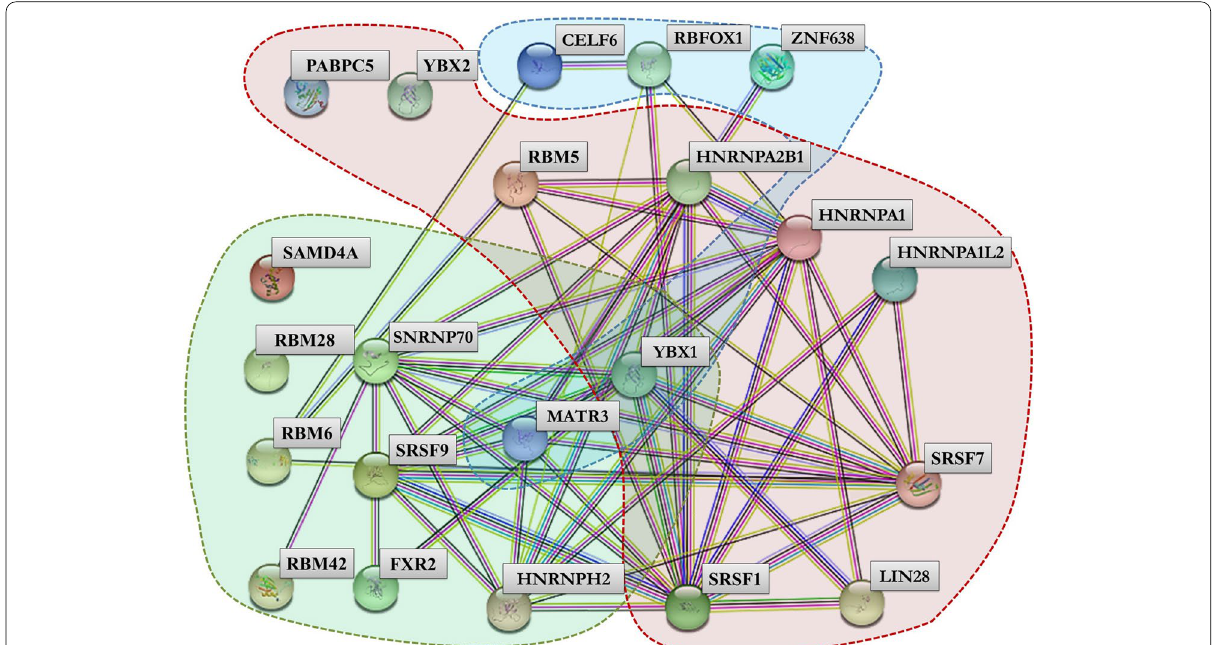
Fig. 2 STRING output showing the possible connection between RBPs. The specific RBPs capable of binding the identified target are highlighted in red, light blue, and